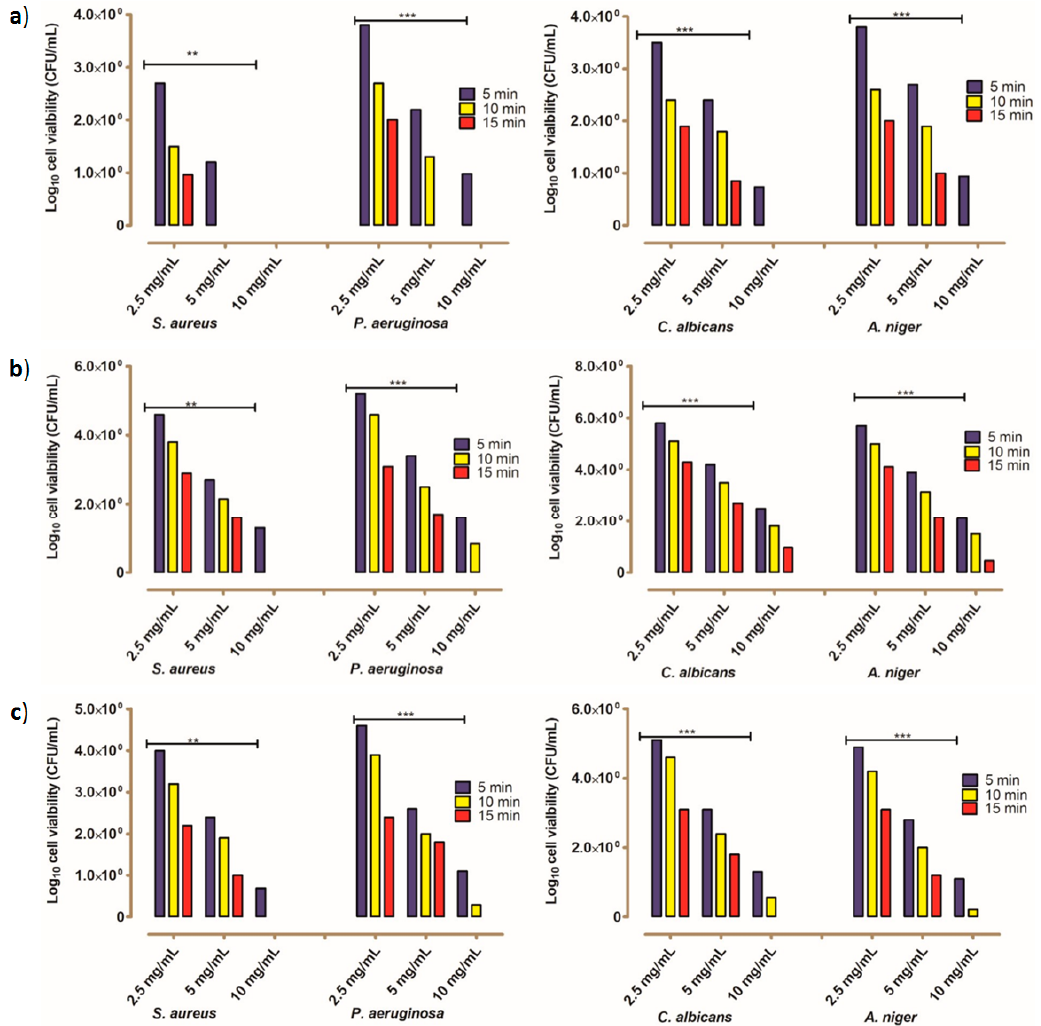
Figure 2. Minimum inhibitory concentration values of the tested compounds ( a ) 5 , ( b ) 6, and ( c ) 7 towards targeted microbes. The remained viable cell populations at various time intervals of 5, 10, and 15 min, are also shown. Two-way analysis of variance ( ANOVA ) states * indicates low correlation ( p ≤ 0.05), ** indicates moderate correlation ( p ≤ 0.01), *** indicates high correlation ( p ≤ 0.001).